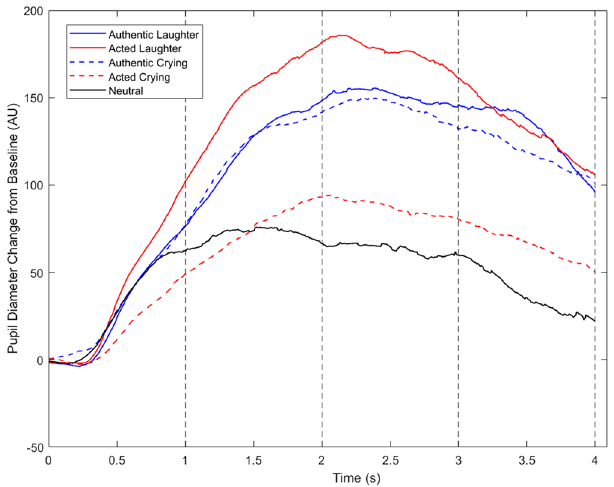
Figure 1. Pupil diameter change relative to baseline (in arbitrary units (AU)) for each condition, averaged across all participants. Dashed vertical lines delineate the time windows used for